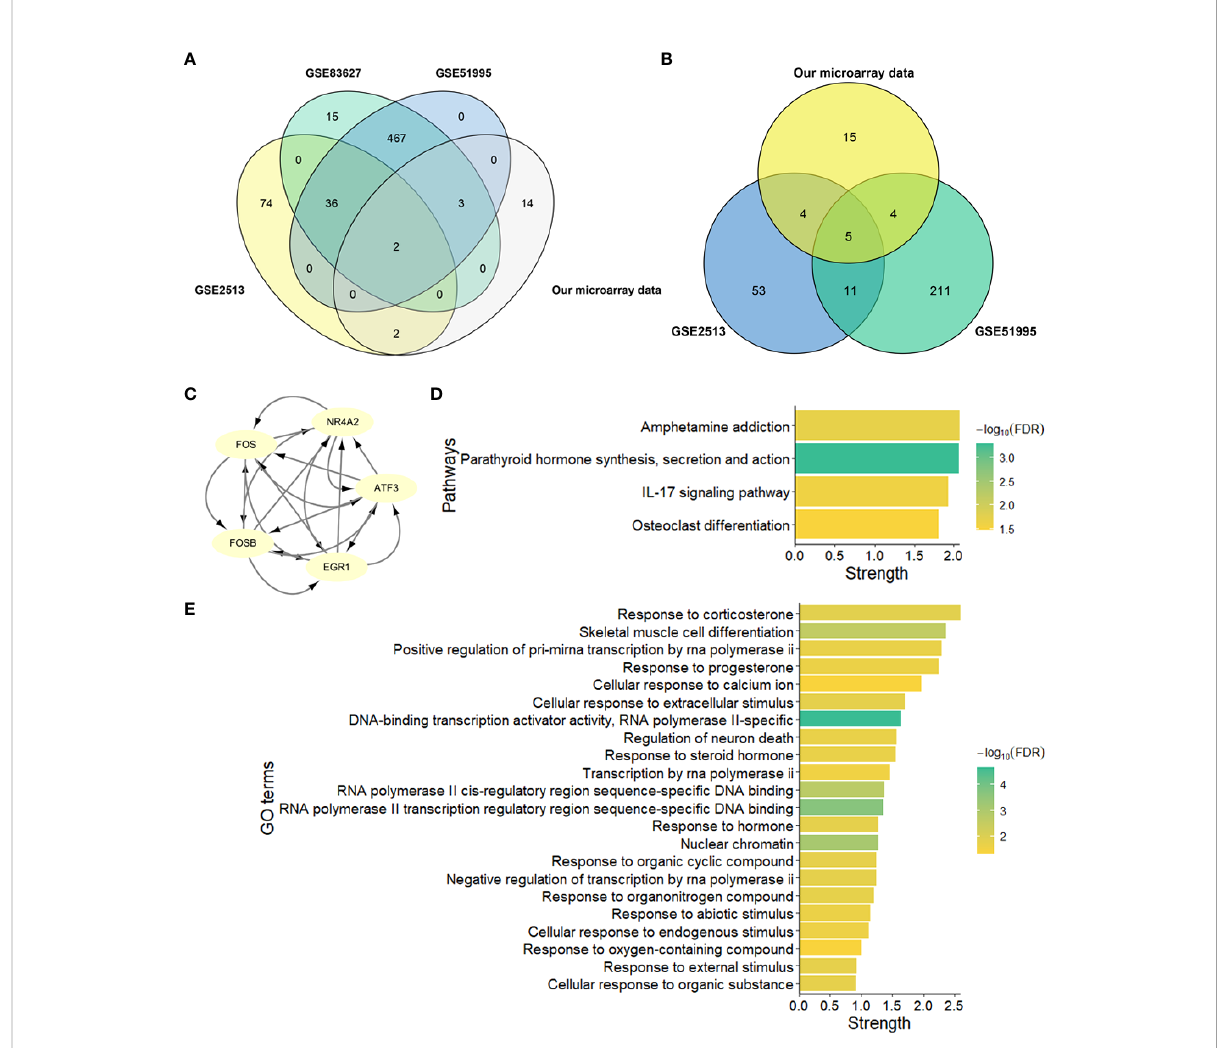
FIGURE 5 Identi fi cation and network enrichment analysis of hub genes. (A) Venn plot of upregulated genes of four microarray data. (B) Venn plot of downregulated genes of four microarray data. (C) PPI network of fi ve downregulated hub genes. There are fi ve nodes and ten edges. (D) KEGG pathway network enrichment analysis of fi ve downregulated hub genes. (E) GO network enrichment analysis of fi ve downregulated hub genes. Strength describes how signi fi cant the enrichment effect is.